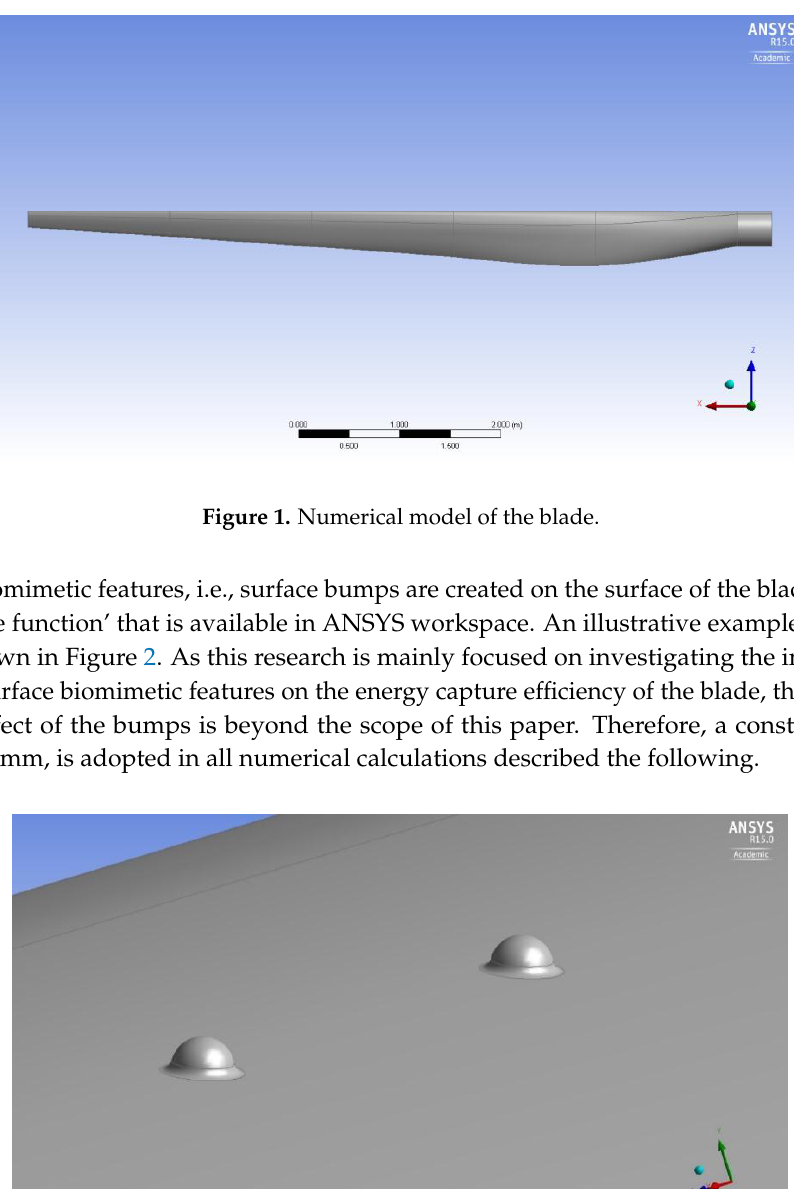
Figure 2. Illustration of the bumps on blade surface.